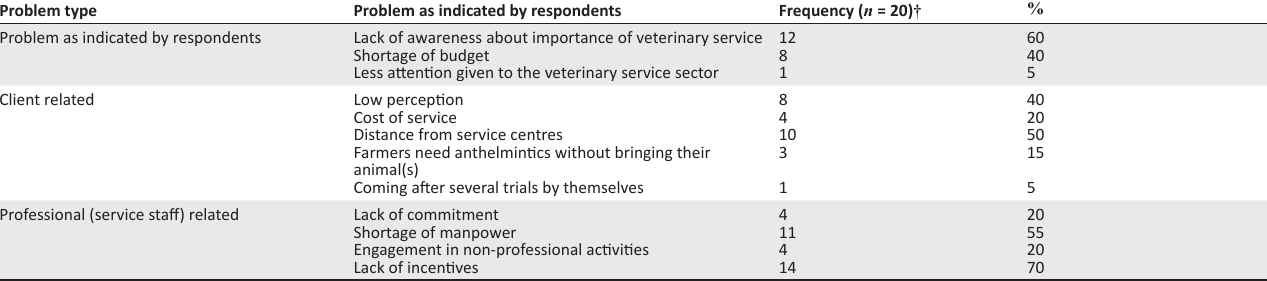
TABLE 6: Problems in public veterinary service.